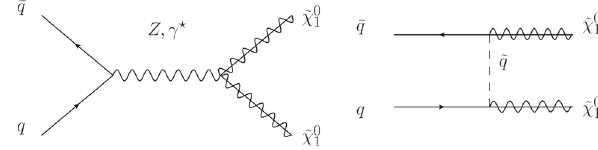
Fig. 3 Feynmandiagrams(atLOQCD)relatedtothedirectproduction of neutralinos